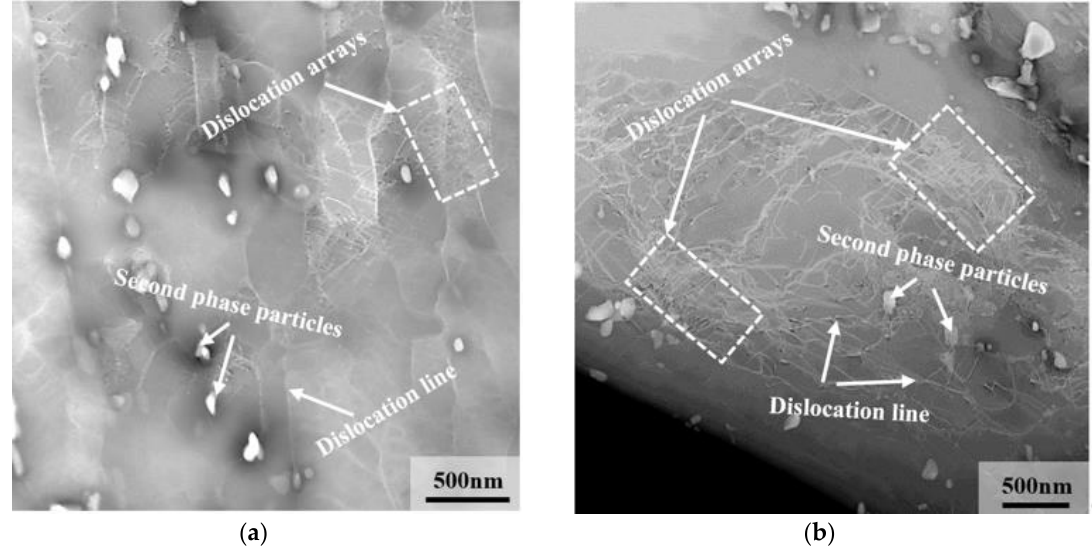
Figure 15. Dislocation distribution of heat-resistant steel under TEM after heat treatment: ( a ) 9Cr– 1.5Mo–1C0 and ( b )